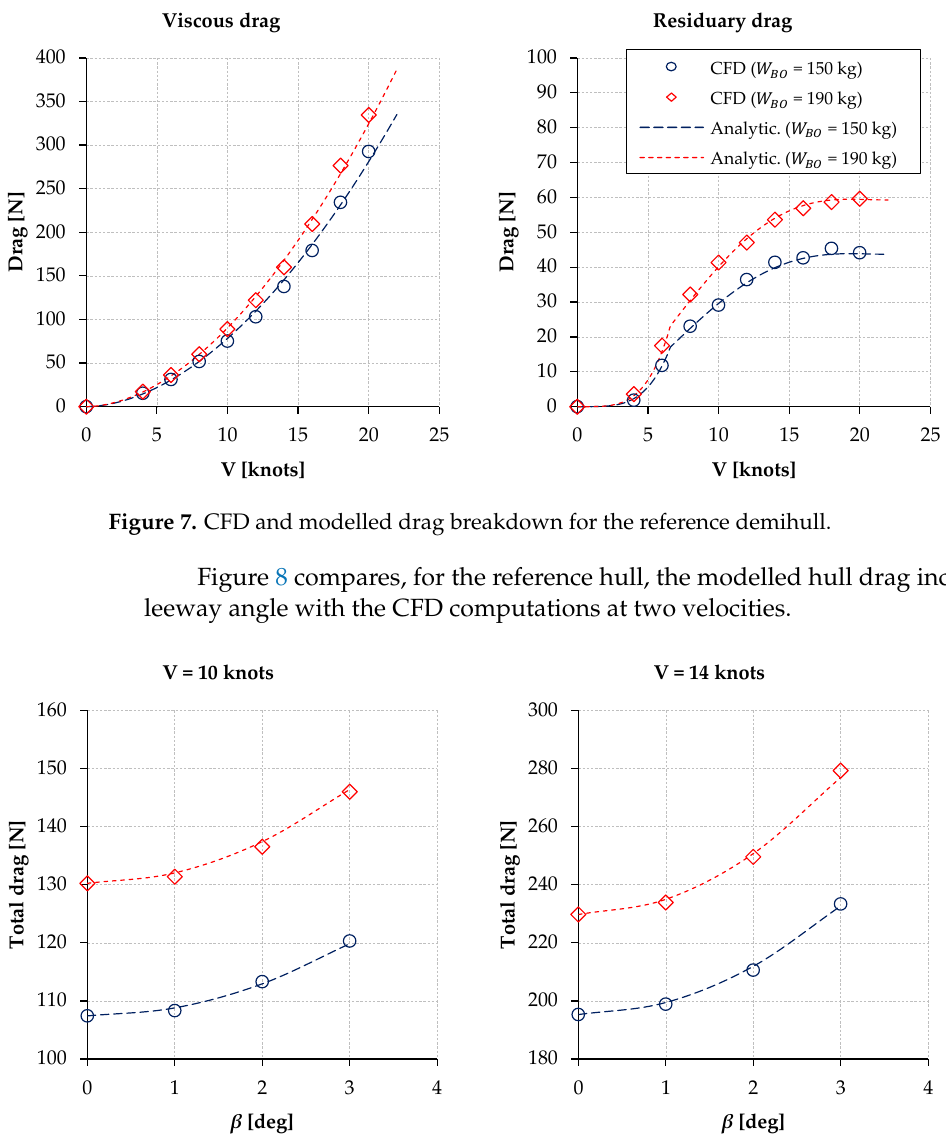
Figure 7. CFD and modelled drag breakdown for the reference demihull.